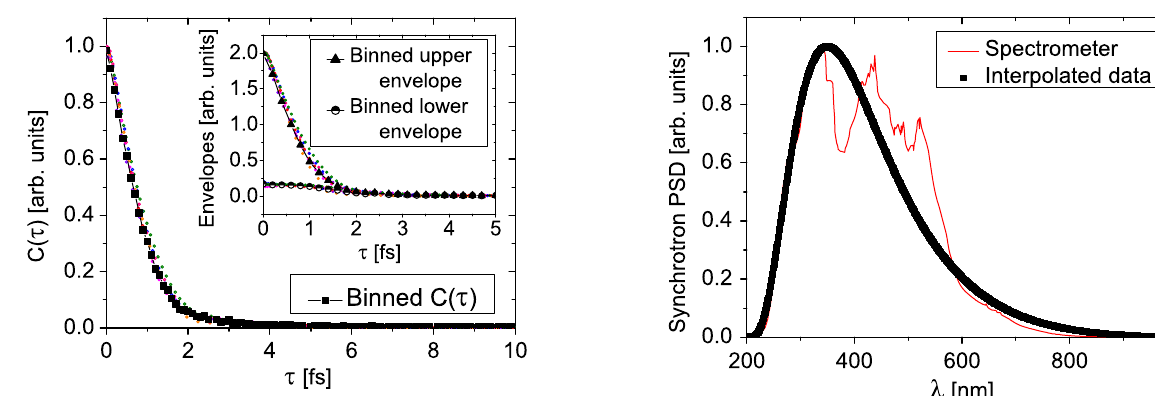
FIG. 18. Synchrotron power spectral density PSD retrieved with the HNFS technique (squares) and measured with a spectrometer (red solid curve). The overall shape of the spectrum has been satisfactorily reproduced, despite the three narrow peaks have not been retrieved (see text for